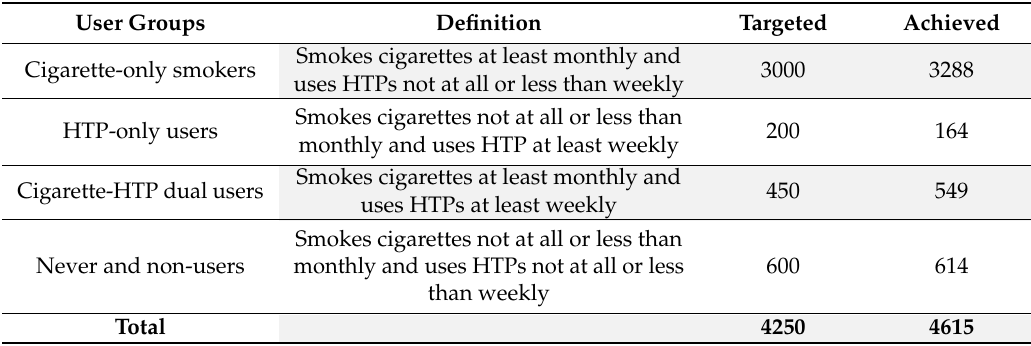
Table 2. ITC Japan Wave 1 Survey sample sizes and definition of the user